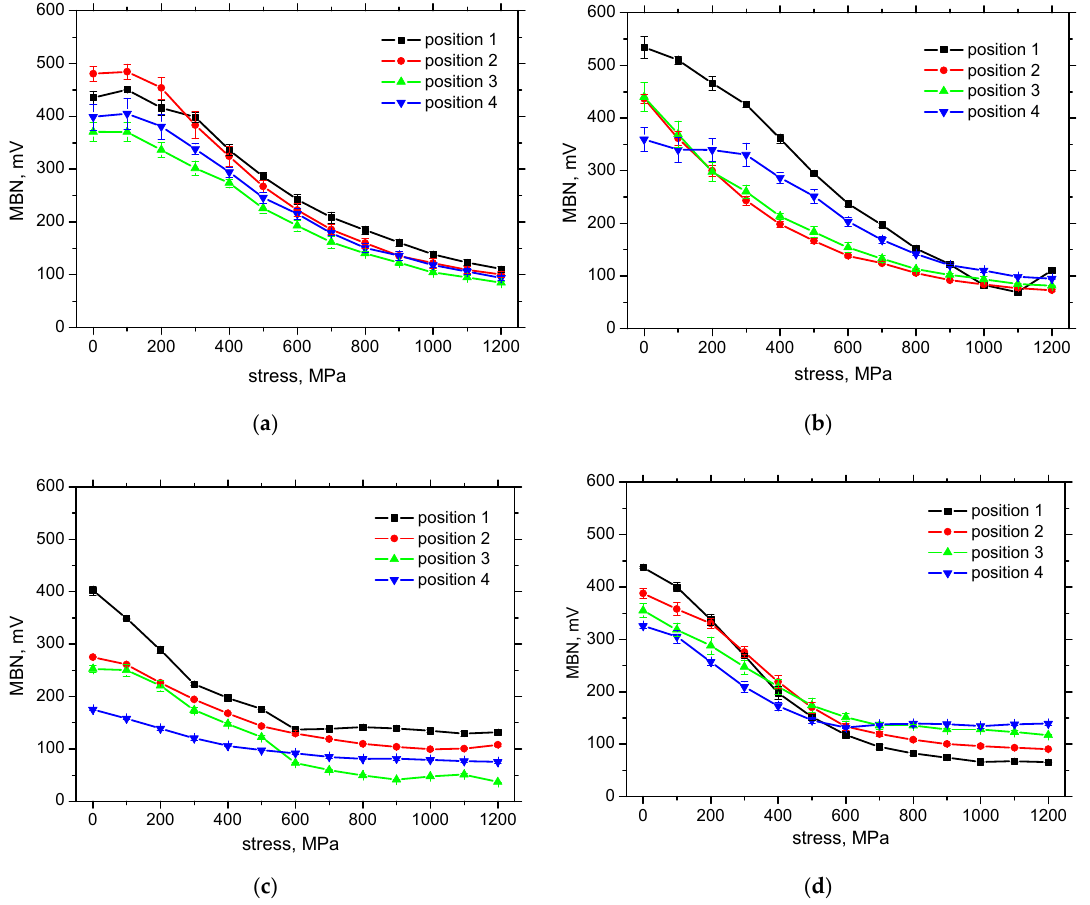
Figure 12. MBN versus tensile stress: ( a ) conventional, ( b ) phosphated, ( c ) galvanized, ( d ) compacted.